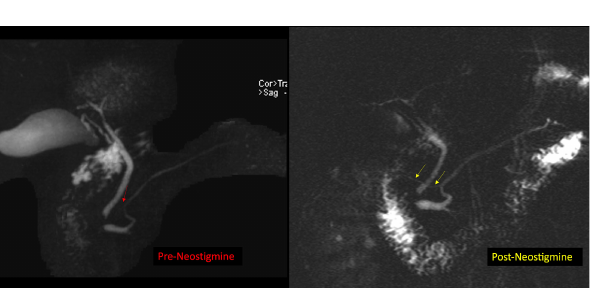
Figure 3. Coronal image from MR cholangiopancreatography of a 61-year-old male patient with a history of recurrent pancreatitis. In baseline cholangiographic sequences, the accessory duct (Santorini) is not seen (red arrow). After administration of Neostigmine ® , the main pancreatic duct diameter is increased and the Santorini duct is clearly represented (yellow arrows) connected to the main pancreatic duct.